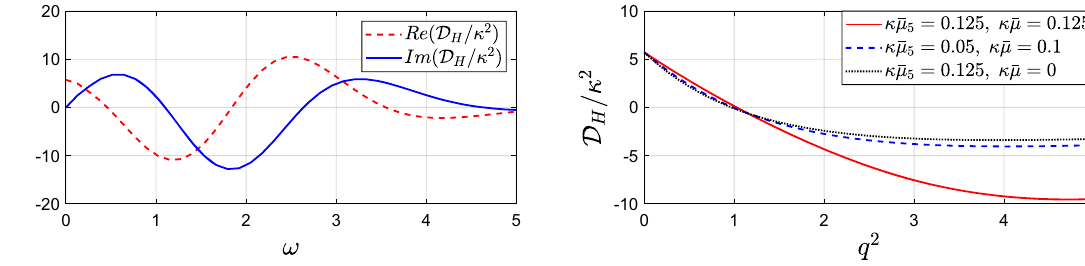
Fig. 6 ω -dependence of D H when q = 0. Here D 0